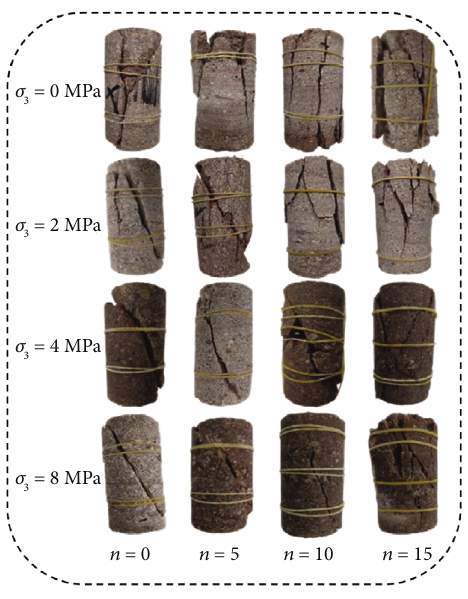
Figure 7: Sample failure